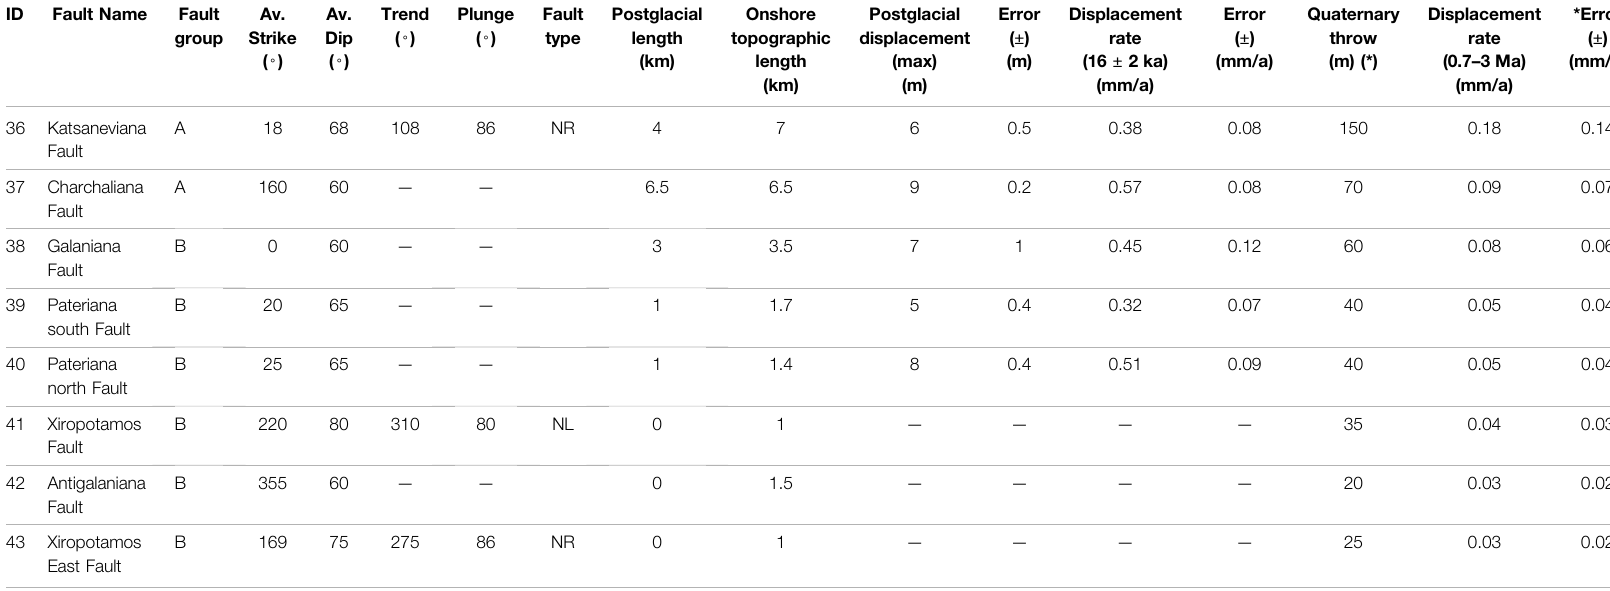
TABLE 2 | Table illustrating the main structural and kinematic characteristics of each fault on the island of Antikythira (*error is calculated as +40% and − 20% of the total throw measurement; see text for